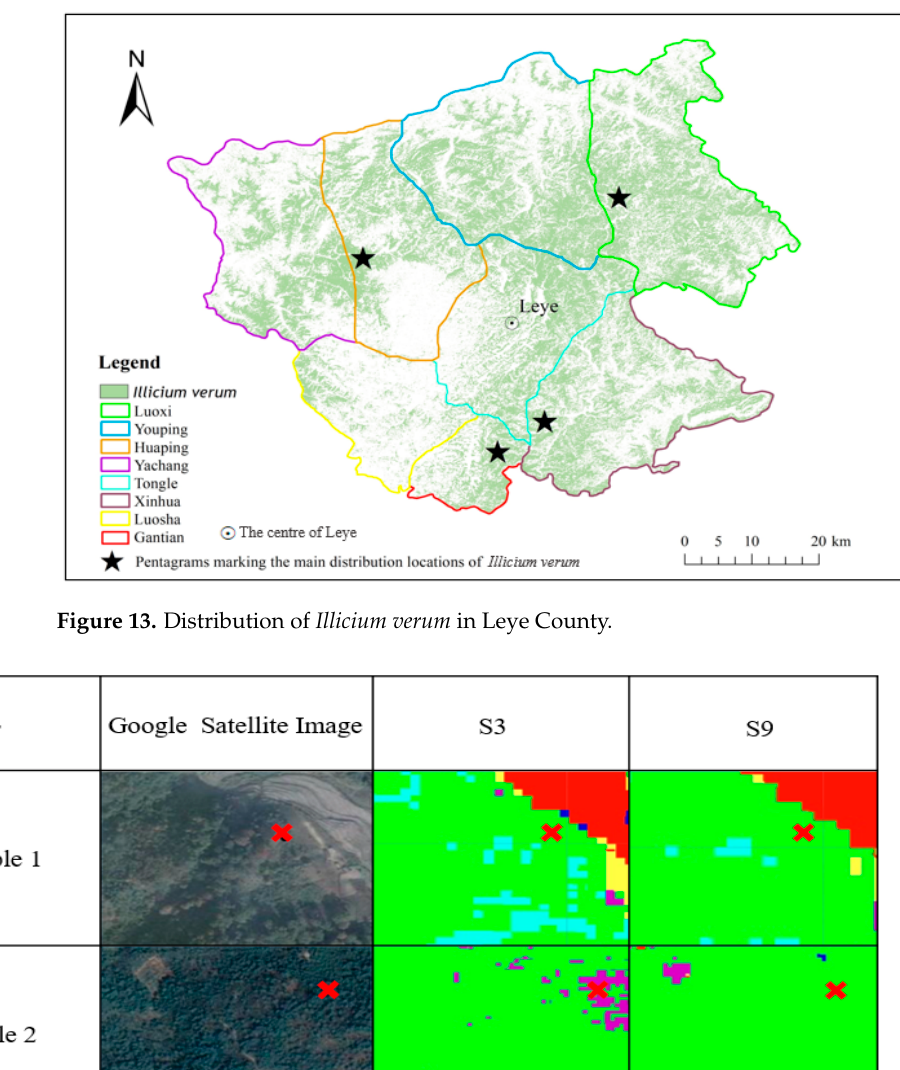
Figure 13. Distribution of Illicium verum in Leye County.